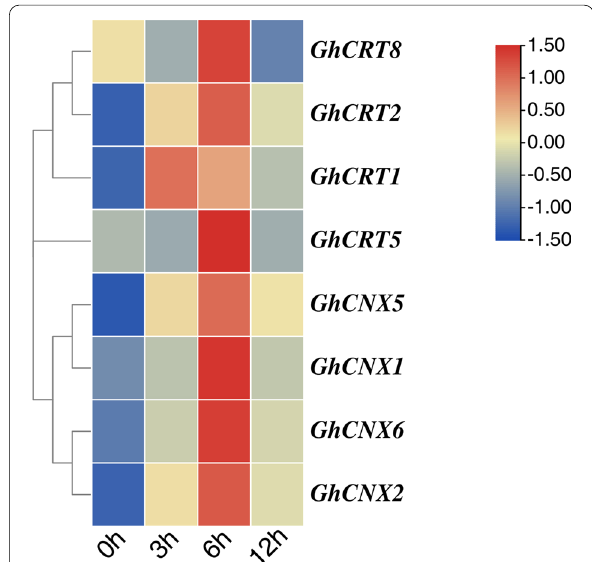
Fig. 9 Select 8 genes specifically expressed in leaves, quantitative real-time PCR detection of the differential expression under four different time duration (0, 3, 6, and12 h) under 12% PEG6000 treatment, and visualize the analysis by heat